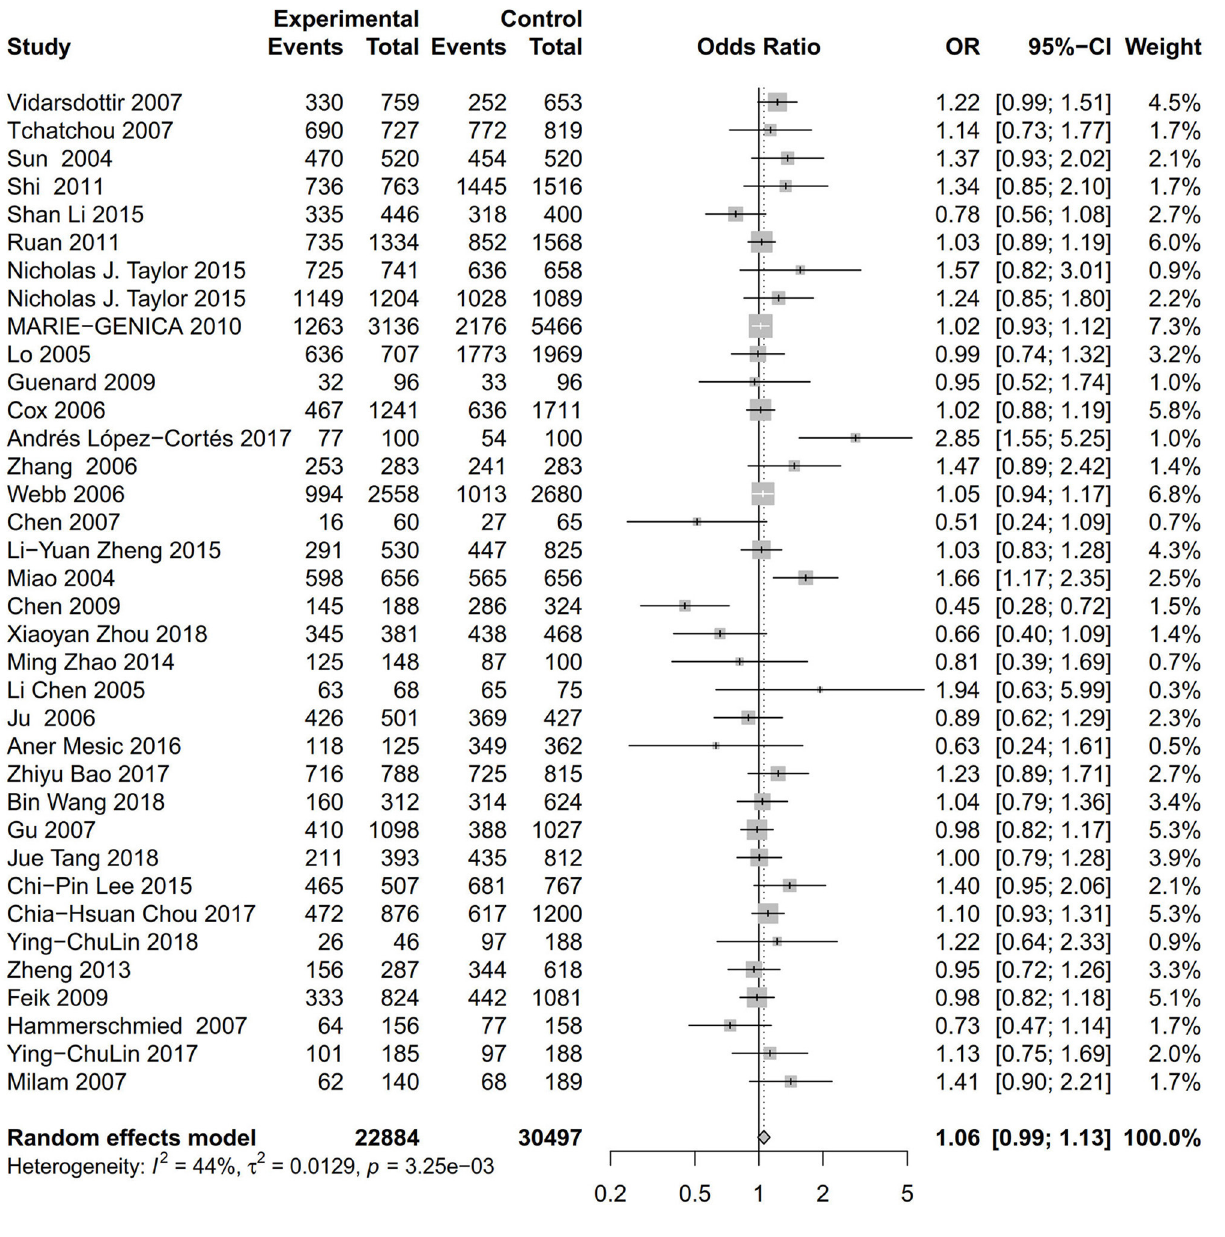
CI = 1.01-1.18). Moreover, the association remained significant in the subgroups with population-based studies (homozygous: OR = 1.25, 95% CI = 1.07-1.46; recessive: OR = 1.19, 95% CI = 1.07-1.33; allele: OR = 1.10, 95% CI = 1.03-1.19) and moderate risk of bias (homozygous: OR = 1.17, 95% CI = 1.02-1.34; recessive: OR = 1.17, 95% CI = 1.06-1.29; allele: OR = 1.08, 95% CI = 1.02-1.14). Figure 6 revealed stratification T > A polymorphism and cancer risk by risk of bias under the homozygous